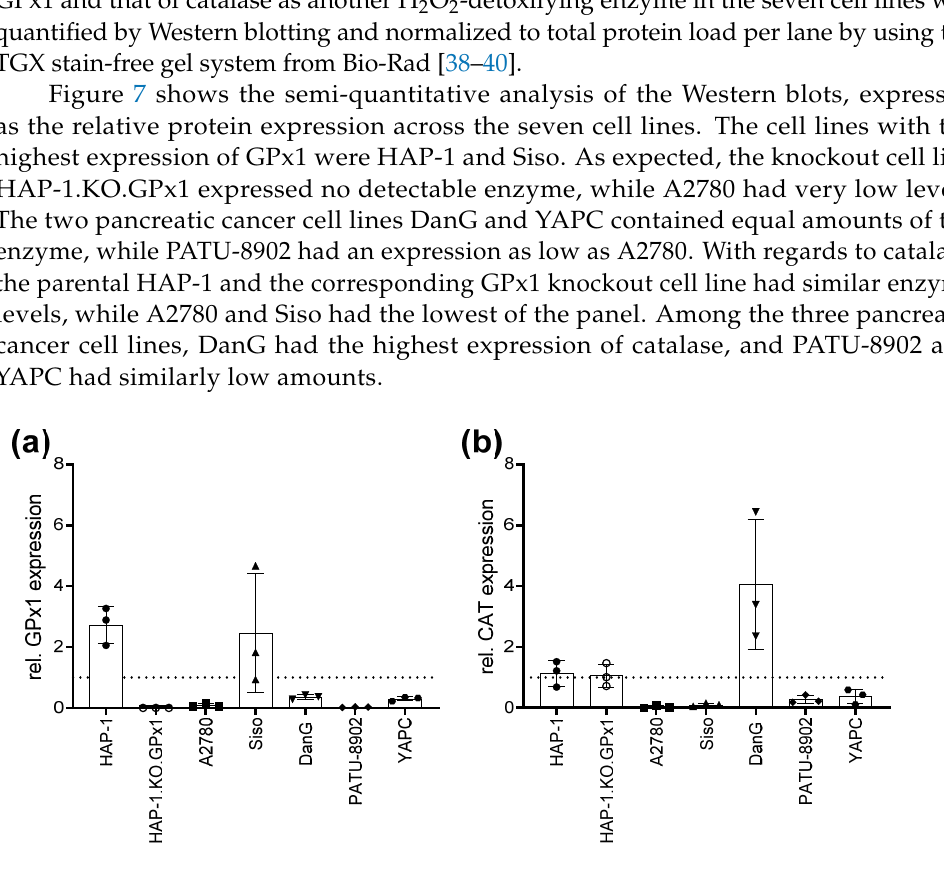
Figure 7. Relative expression of GPx1 ( a ) and catalase ( b ) in the seven cell lines used for selected biological assays to determine the effects of the pentathiepins 1 – 6 displayed as single values with mean and SD. Protein levels were determined by Western blotting and normalized to total protein load per lane (original images Figures S35–S38). For each protein, a mean was calculated throughout all cell lines (set to 1, dashed line) and all single values related to it. n = 3 independent experiments.